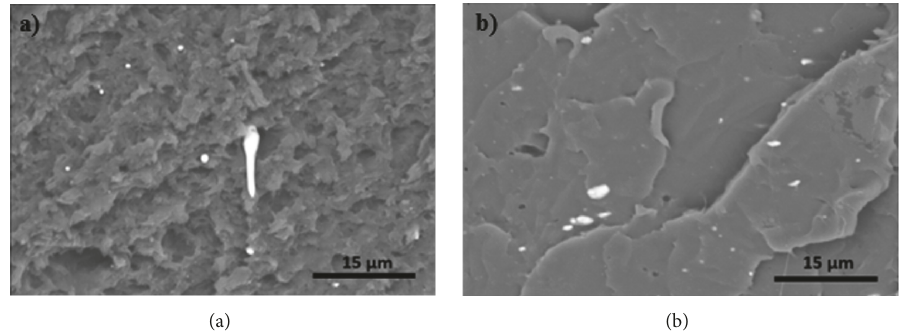
Figure 4: Fracture surface of 5% P-glass loaded into (a) ABS:SEBS-g-MA and (b) PLA.